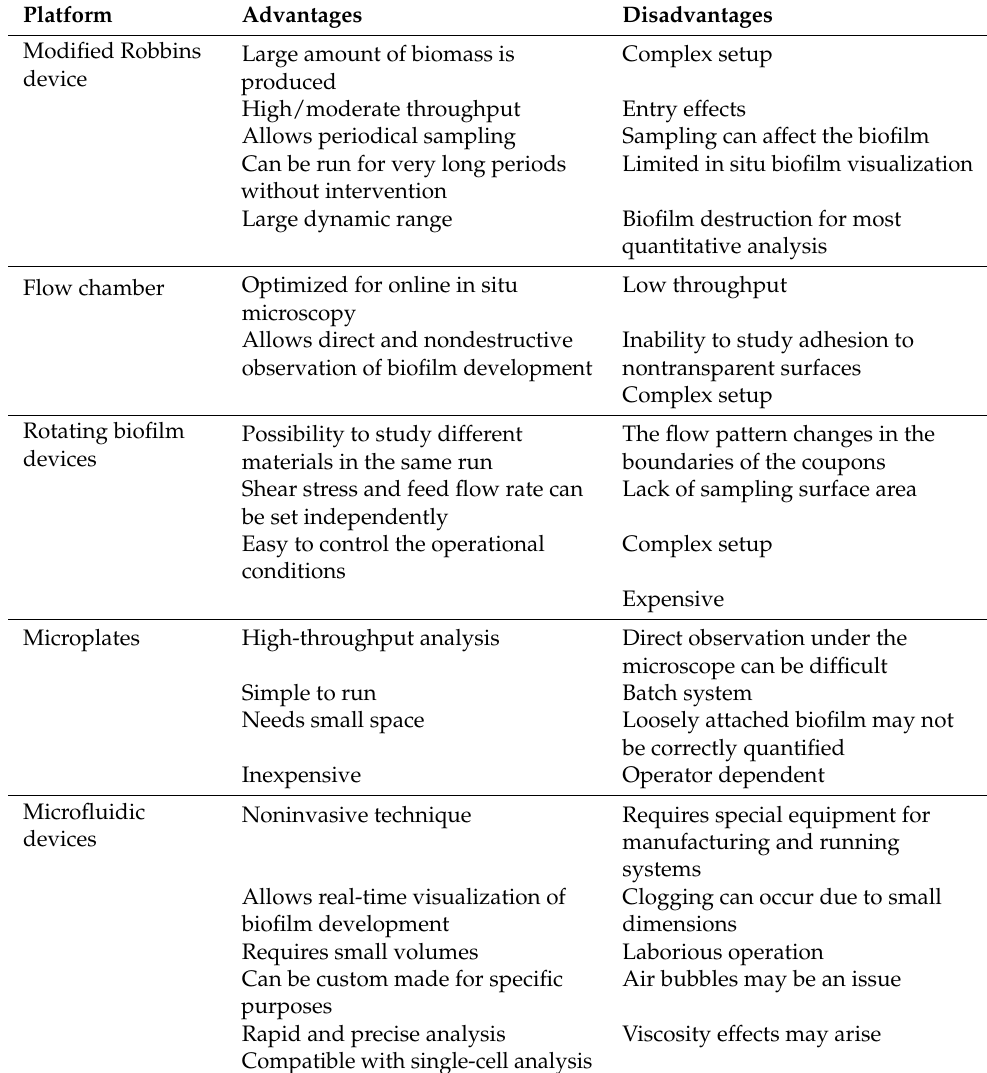
Table 1. Main advantages and limitations of standard platforms for in vitro biofilm studies